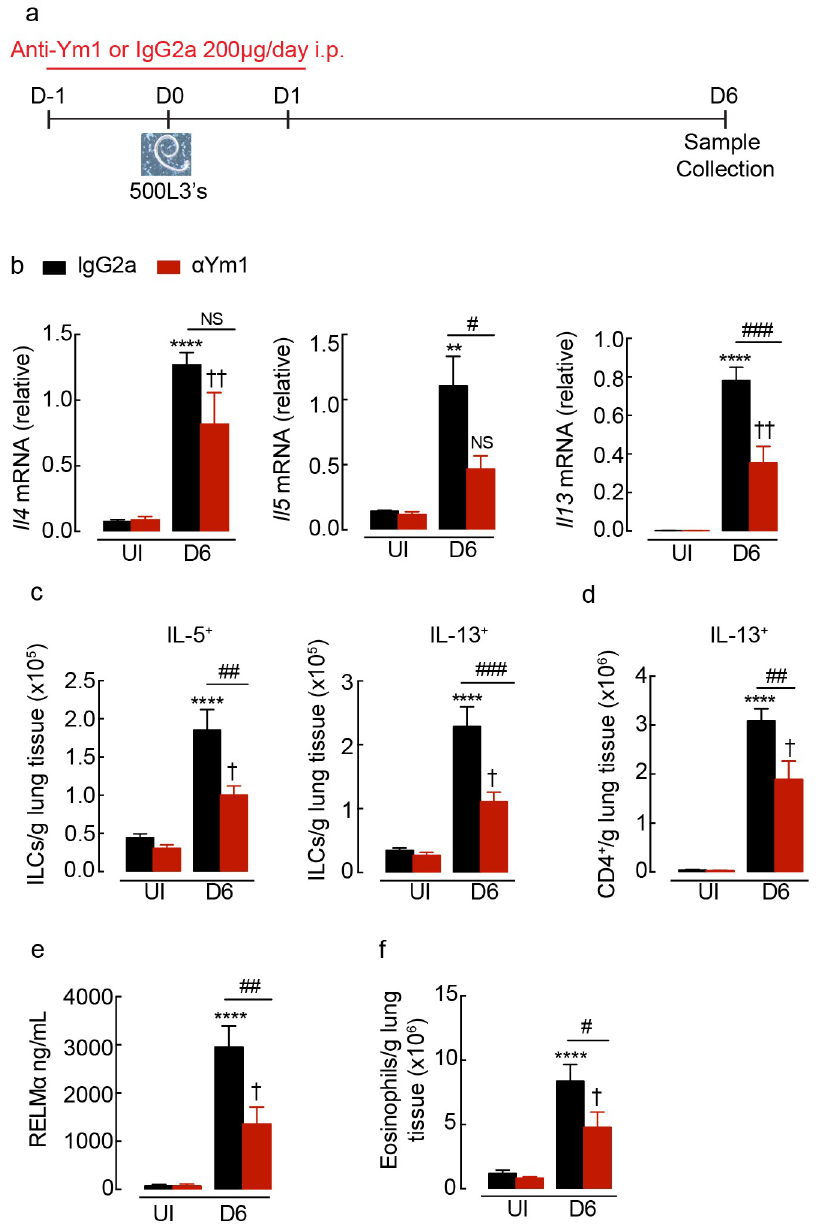
Fig 2. Innate Ym1 promotes type 2 cytokine production in the lung during N . brasiliensis infection. (a) Time-line of infection with N . brasiliensis (500 L3’s) and dosing with anti-Ym1 or IgG2a. (b) Expression of Il4 , Il5 and Il13 mRNA in whole lung tissue of uninfected (UI) or N . brasiliensis infected mice (D6) treated intraperitoneally with anti- Ym1 or IgG2a ( n = 6 per group; data are shown as mean ± sem; two-way ANOVA with Sidak multi-comparison test; NS not significant, �� P < 0.01 ���� P < 0.0001 compared to UI IgG2a treated; ✝✝ P < 0.01 compared to UI anti-Ym1; #P < 0.05 and ### P < 0.001 IgG2a infected compared to anti-Ym1 infected mice; data representative of 2 independent experiments). (c) The number of ILC2s expressing intracellular IL-5 or IL-13 within the lungs of mice as in b . Single cell lung suspensions were stimulated ex vivo with PMA and ionomycin, graphs show absolute number of cytokine positive cells per g of lung tissue ( n = 6 per group; data are shown as mean ± sem; two-way ANOVA with Sidak multi- comparison test; ���� P < 0.0001 compared to UI IgG2a treated; ✝ P < 0.05 compared to UI anti-Ym1; ##P < 0.01 and ### P < 0.001 IgG2a infected compared to anti-Ym1 infected mice; data representative of 2 independent experiments). (d) Expression of IL-13 in CD4 + T cells from mice as described in b . (e) RELM α levels secreted into the BAL of mice as in b ( n = 6 per group; data are shown as mean ± sem; two-way ANOVA with Sidak multi-comparison test; ���� P < 0.0001 compared to UI IgG2a treated; ✝ P < 0.05 compared to UI anti-Ym1; ##P < 0.01 IgG2a infected compared to